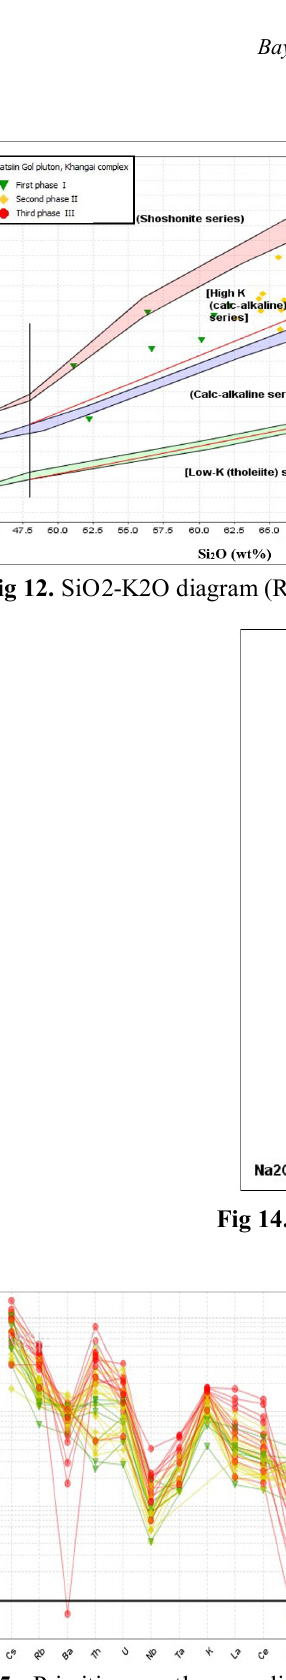
Fig 15. Primitive mantle normalized trace element spider diagram of Taatsiin Gol pluton, Khangai Complex (Sun and McDonough, 1989)